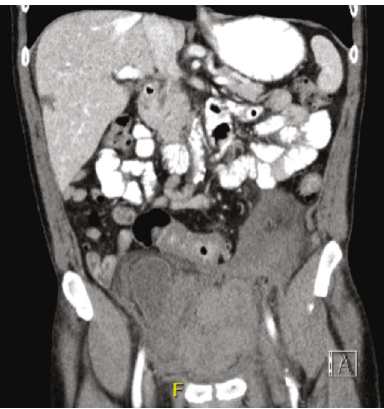
Figure 2: Initial CT abdomen and pelvis in ED (coronal): 16 hours postop with large pelvic hematoma.